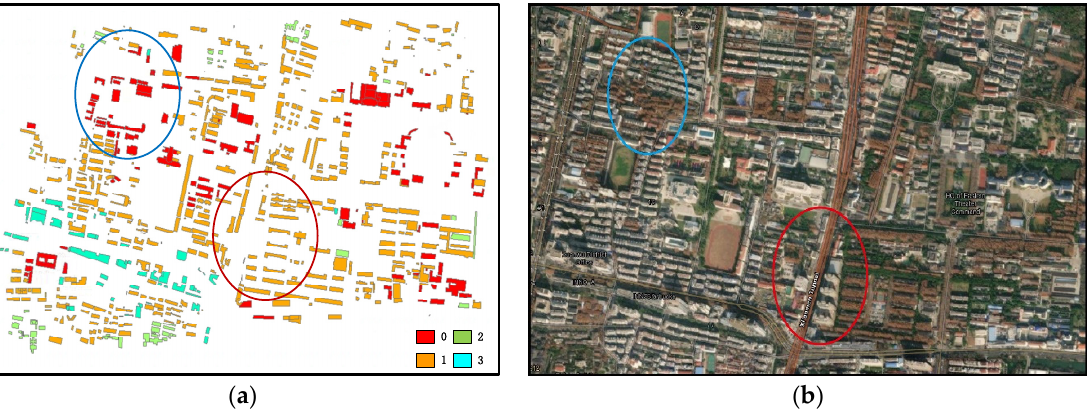
Figure 7. The comparation between ( a ) predicted results and ( b ) actual situation, where 0 represents school buildings, 1 represents residential buildings, 2 represents commercial buildings and 3 represents communal facilities.